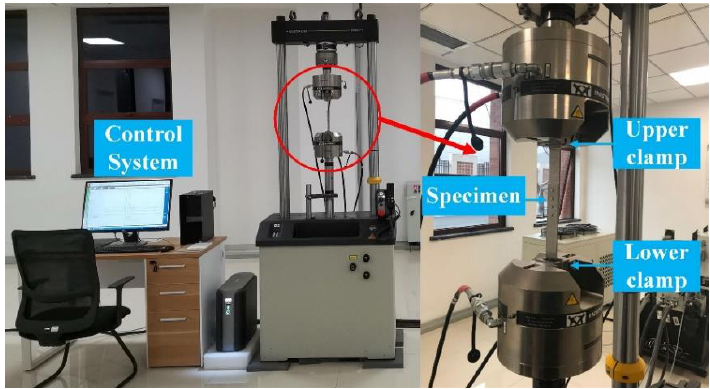
Figure 17. The fatigue tests performed with the INSTRON 8801 fatigue testing machine. Table 8. The fatigue lives and crack sites of the riveted lap